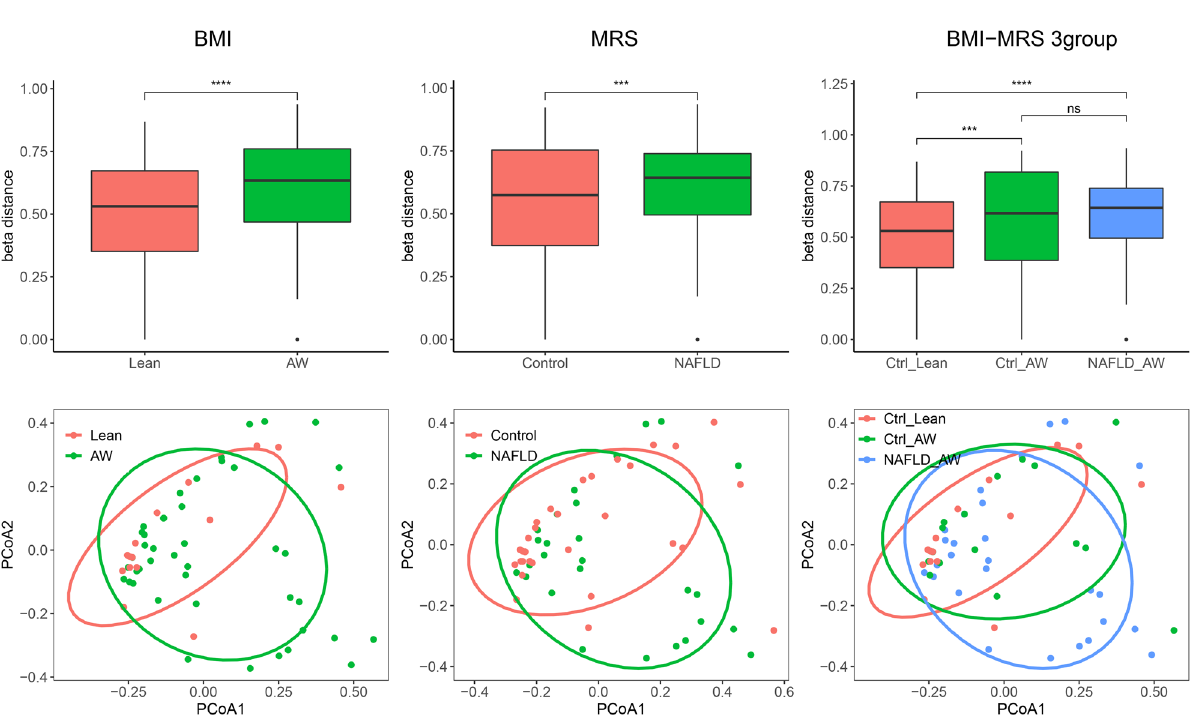
Figure 2. Comparison of gut microbiota ecological diversity between the groups. (Top) The beta diversity is compared between each pair of groups based on the Bray ‒ Curtis distance at the genus level. The comparisons show that the beta-diversity of the AW group and NAFLD group is higher than that of the healthy lean controls (Wilcoxon rank-sum test, P < 0.05) . (Bottom) Principal coordinates analysis (PCoA) plot at the genus level also shows consistent findings on the significant difference in microbial composition between the Ctrl-Lean and NAFLD-AW groups (PERMANOVA, Lean vs. AW, P = 0.065; Control vs. NAFLD, P = 0.121; Ctrl-Lean vs. NAFLD-AW, P = 0.039; Control-AW vs. NAFLD-AW, P = 0.702). Each point represents a single child. Note: “*”, P < 0.05; “**”, P < 0.01; “***”, P <